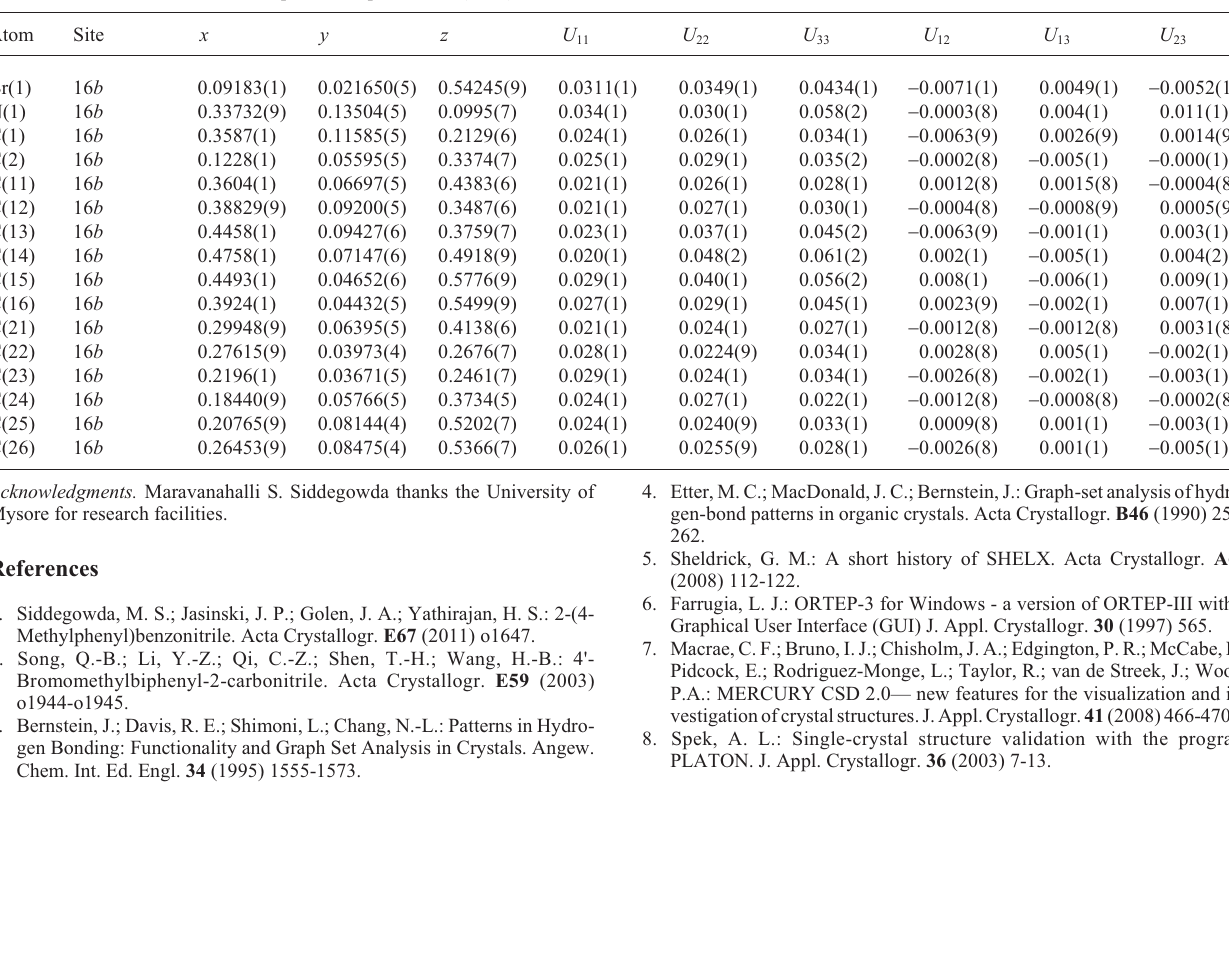
Table 3. Atomic coordinates and displacement parameters (in Å 2 )